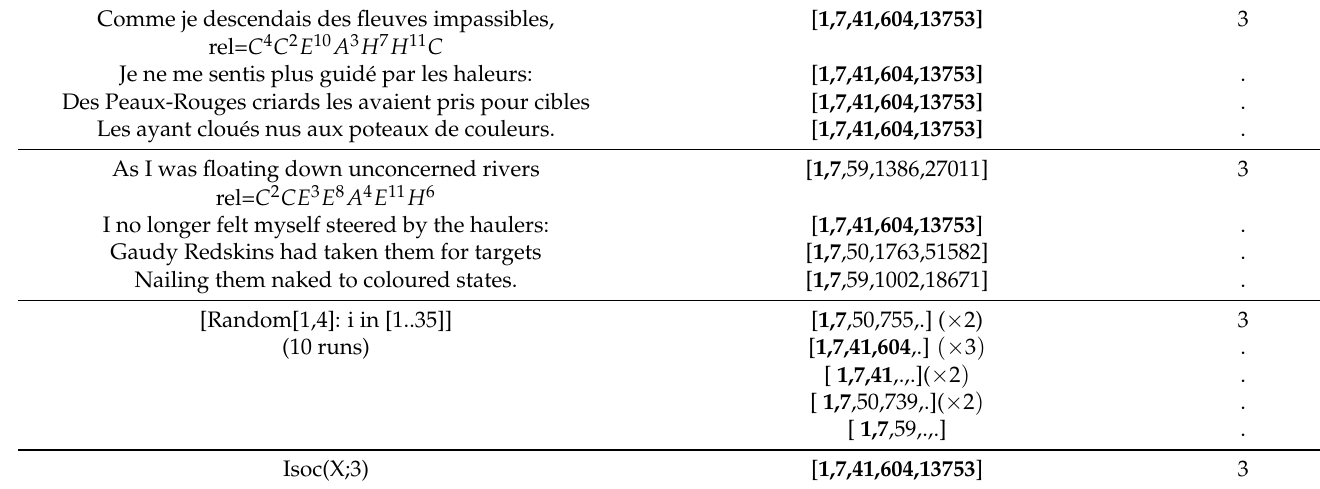
Table 7. The same as in Table 6, but each line is split into segments encoded by the symbol H (for names and adjectives), E (for verbs), A for prepositions, or C (for the other types: conjunctions, adverbs, punctuation marks and so on). The cardinality structure of cc of subgroups of a small index is compared to the one obtained with 10 runs of a sequence of random 4-letter words of similar length (i.e., the length